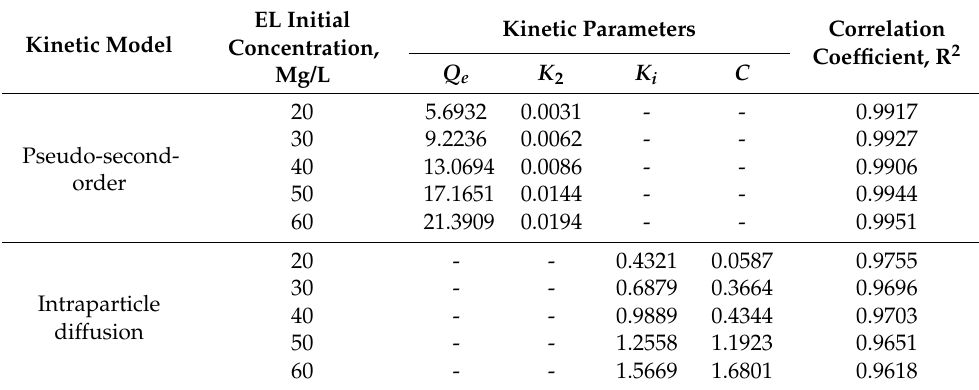
Table 1. Biosorption kinetic parameters of EL on synthesized